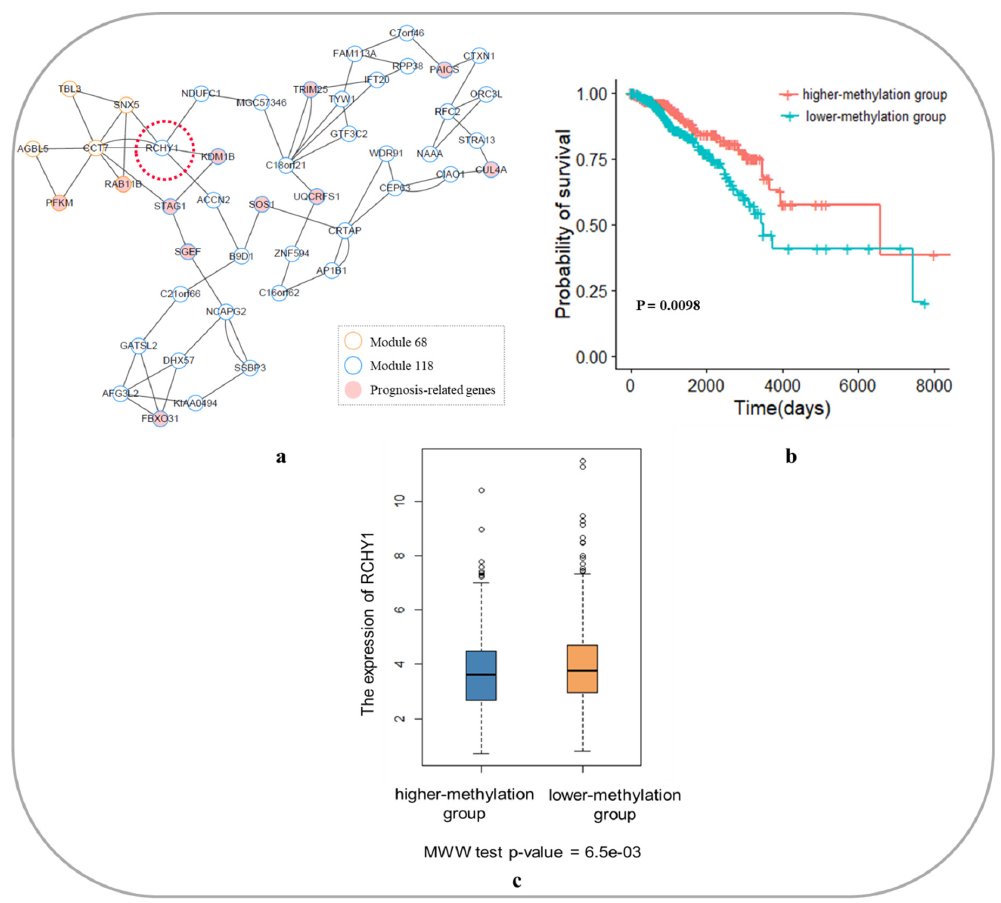
Figure 7. Core module network and survival analysis of RCHY1 as a biomarker in breast invasive carcinoma. ( a ) Core module network of breast invasive carcinoma; ( b ) Survival analysis of RCHY1 as a biomarker in breast invasive carcinoma; ( c ) The expression of the gene RCHY1 in higher-methylation group and lower-methylation group. MWW: